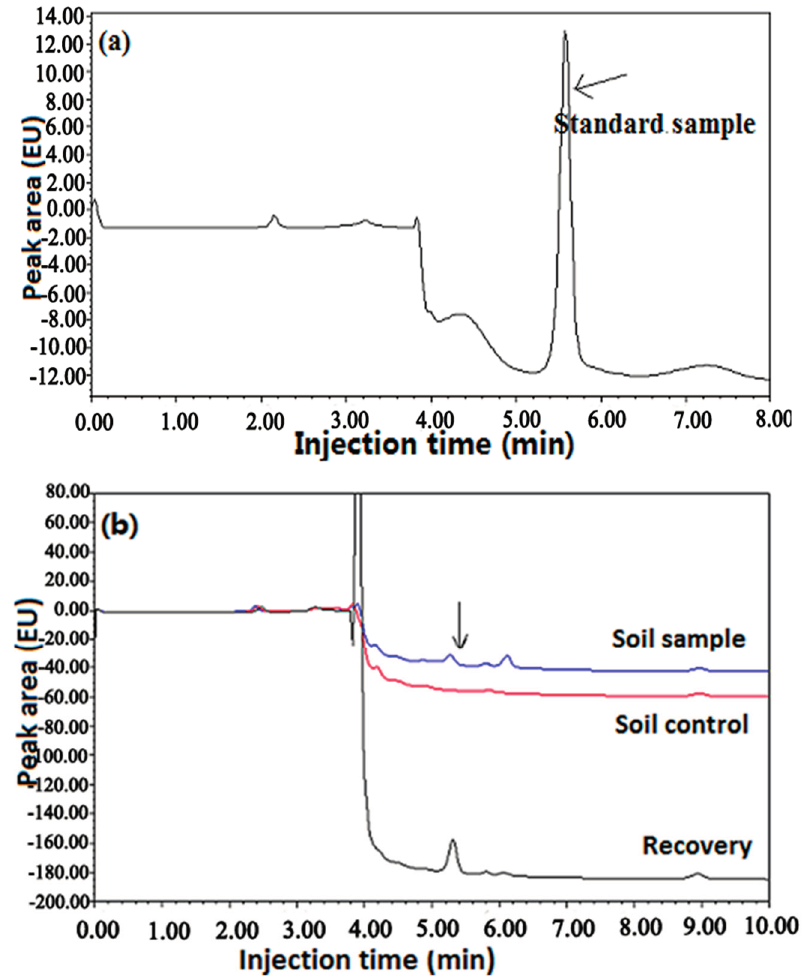
Figure 3. Chromatogram of glyphosate ( a ) ddH 2 O and ( b ) soil samples in 2011 field